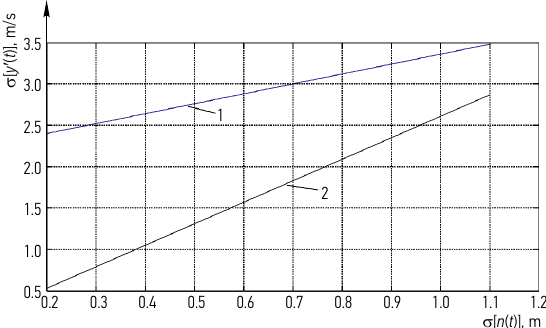
Fig. 2. Standard deviations of the theoretical derivative (car speed), numerically calculated by using the classical (1) and offered (2)